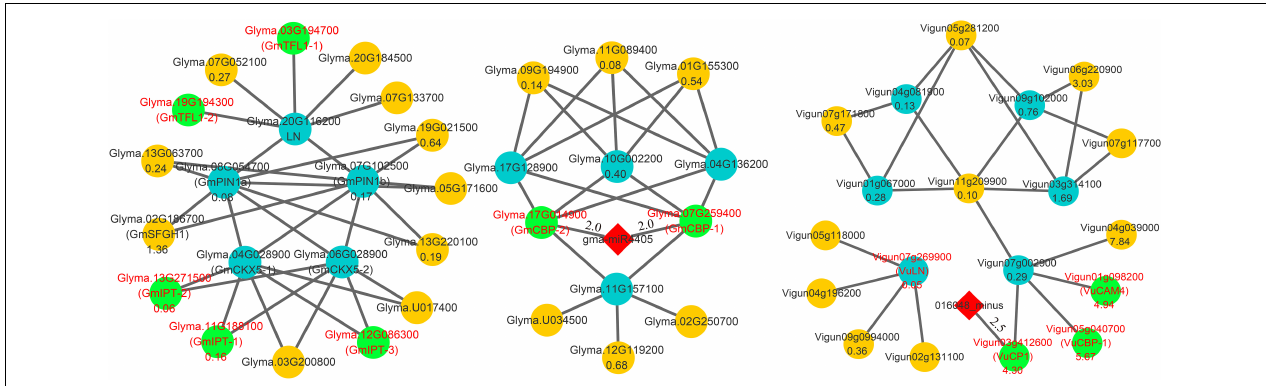
FIGURE 5 | Main interaction networks on SNPP-related genes in soybean and cowpea. All the genes that encode Isopentenyltransferase, TERMINAL FLOWER 1, and calmodulin and calcium-binding proteins were marked by red color characters and green background.